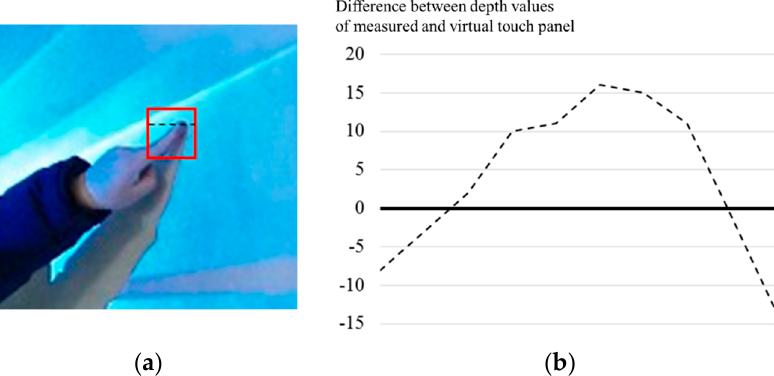
Figure 5. Difference between depth values of measured and virtual touch panel in position of touch: ( a ) original picture; ( b ) difference of depth values from virtual touch panel.